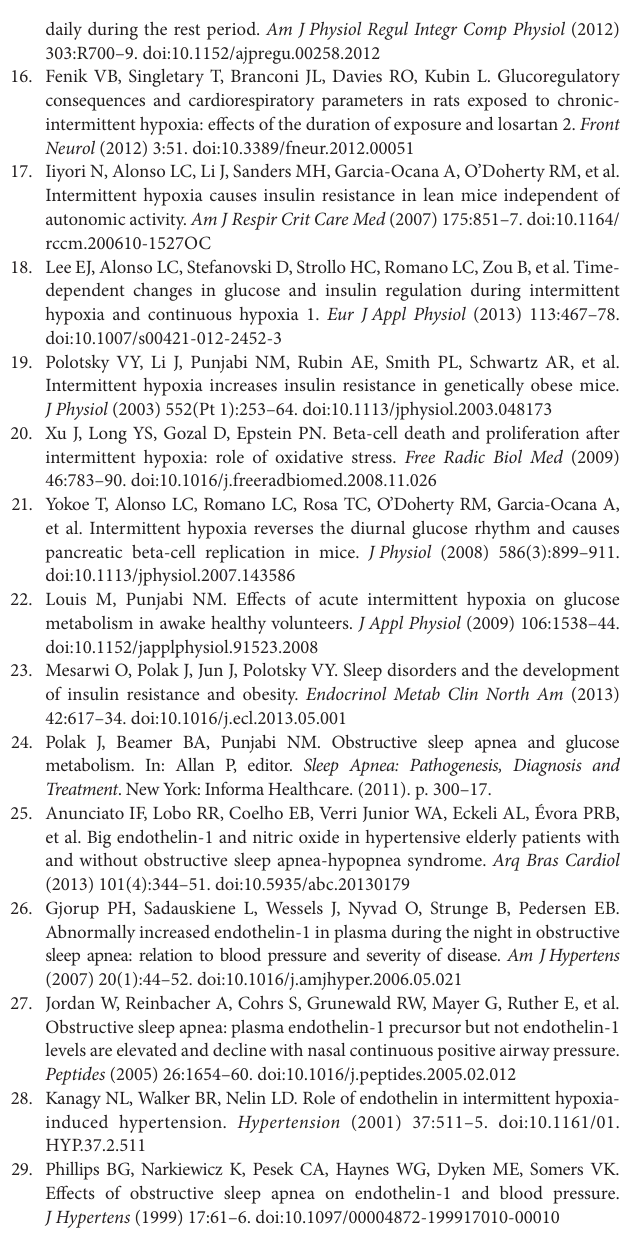
FigUre s1 | Estimated food intake during exposures. The amount of food provided daily per cage and food left the next day per cage was recorded. No differences were observed between groups, however this does not represent the true food intake of individual animals (some food is lost in bedding during chowing, etc...).